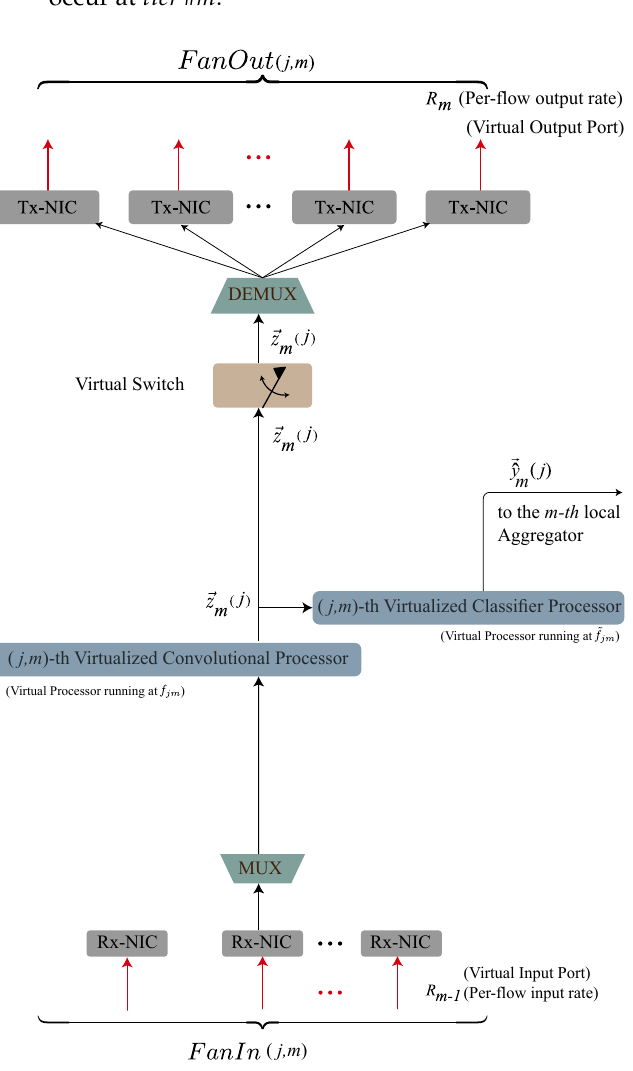
Figure 6. Envisioned virtualized architecture of Fog ( j , m ) . It is hosted by a container and im- plemented by the associated virtualized clone. NIC: Network Interface Card; MUX: Multiplexer; DEMUX: